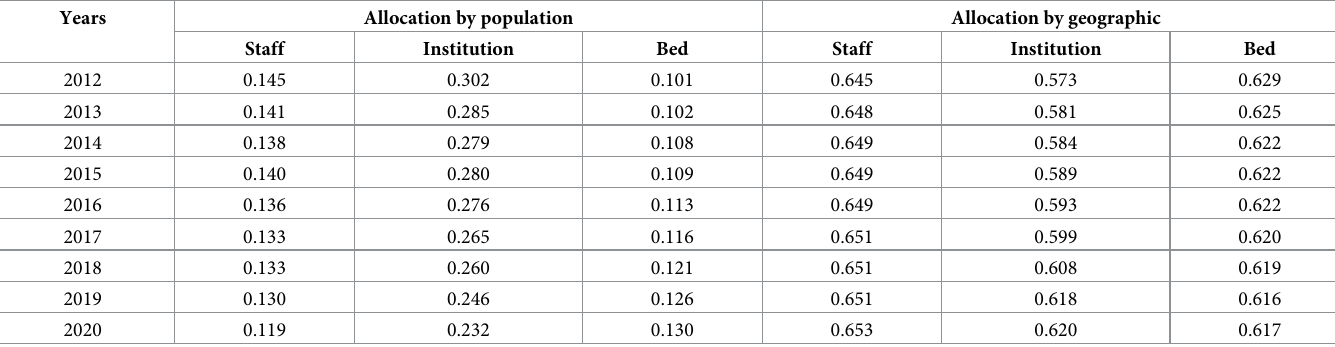
Table 2 shows the G index of the three indicators against population size and geographical area in different years. From a population perspective, the G index of institutions reduced from 0.302 to 0.232, representing an increase from proper equality to relative equality. The G index of beds increased from 0.101 to 0.130, indicating that although equity was reduced, it was still within the absolute equity range. The G index of health staff decreased from 0.145 to 0.119, representing increasing equity. However, the G indices as a function of geographical area were all greater than 0.6 in 2020, which indicates poorer equity. Fig 1 presents the Lorenz curves and the changes in the G index of the three indicators. The institution and health worker curves based on population are closer to the absolute equality curve, whereas the bed curve is farther away from the absolute equality curve. In contrast, the three indicator curves based on geographic area show the opposite performance. Tables 3 and 4 show the HRADs of the three input indicators based on geographic area and population, respectively, in Eastern, Central and Western China. From the perspective of geographic area, the HRADs of institutions, beds and health personnel in the Eastern region Table 2. The Gini coefficients of TCM health resources from 2012 to 2020. Years Allocation by population Allocation by geographic Staff Institution Bed Staff Institution